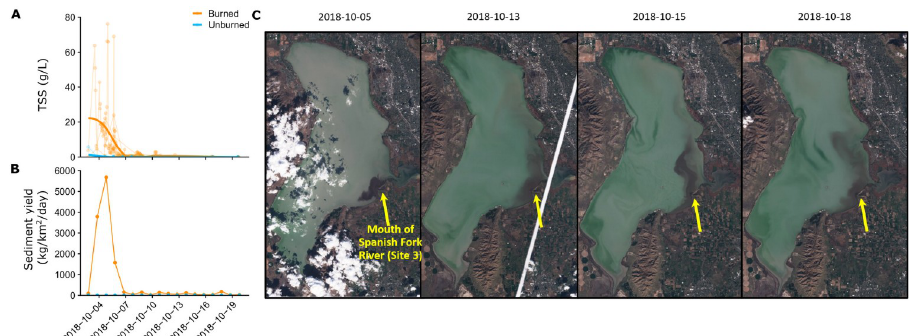
Fig 2. Sediment concentration and flux from burned and unburned watersheds. Total Suspended Sediment (TSS) is the mass of particles retained during filtration to 0.7 μ m expressed per liter. Sediment yield is the flux of sediment normalized by watershed area. A ) Individual measurements for each site (translucent points and lines) and the smoothed mean for burned and unburned sites (solid blue and orange lines). B) Cumulative daily values of sediment yield for the burned and unburned site with a USGS gauging station. C) Satellite imagery from the storm period. Copernicus Sentinel data retrieved from ASF DAAC in 2019, processed by